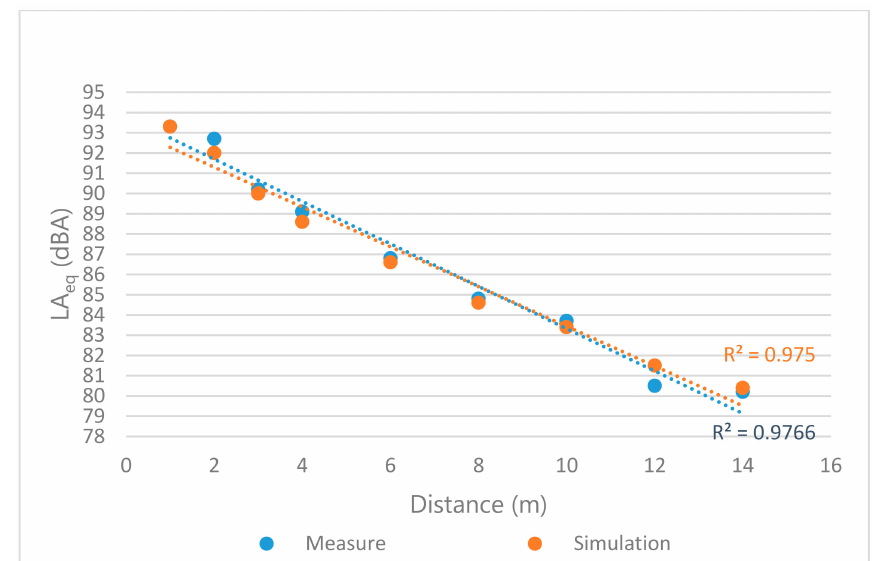
Figure 5. Comparison between simulated and measured values of the Sound Pressure Level (SPL) over the longitudinal dimension of the case study.